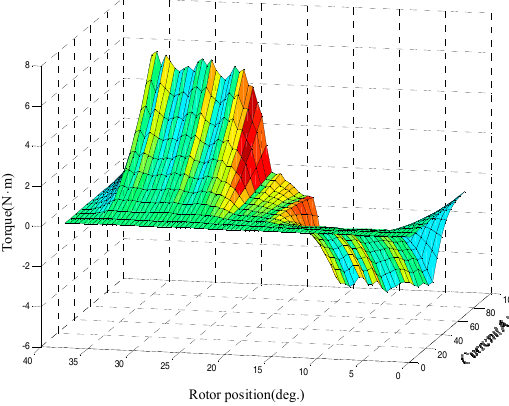
Figure 26. Torque profile of conventional SRM.